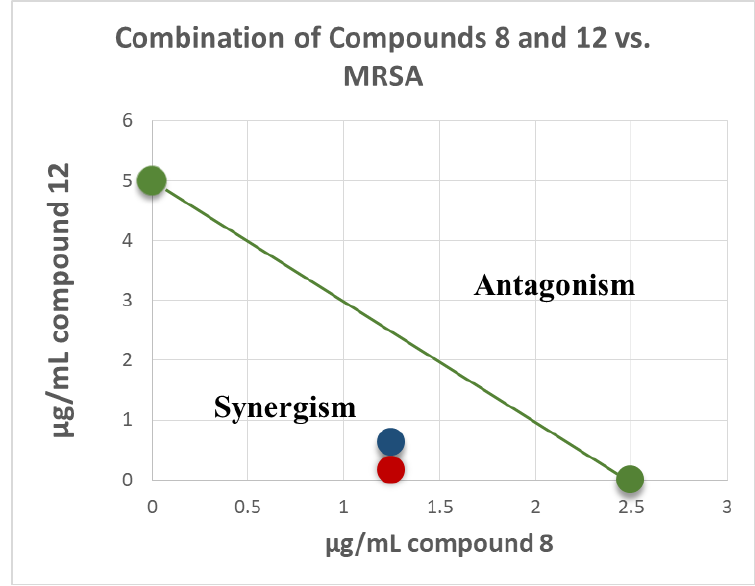
Figure 4. Isobologram of combination of compounds 8 and 12 in MRSA 1708 (red) and 1717 (blue). The green series represents the additivity line of compounds 8 and 12 green dots represent the MIC of each compound alone; the green line represents all possible additive combinations). The red (MRSA 1708) and blue (1717) dots represent the combination of compounds 8 and 12 , and show that they fell below the additivity line (the combination of compounds produces a synergistic effect beyond additivity).